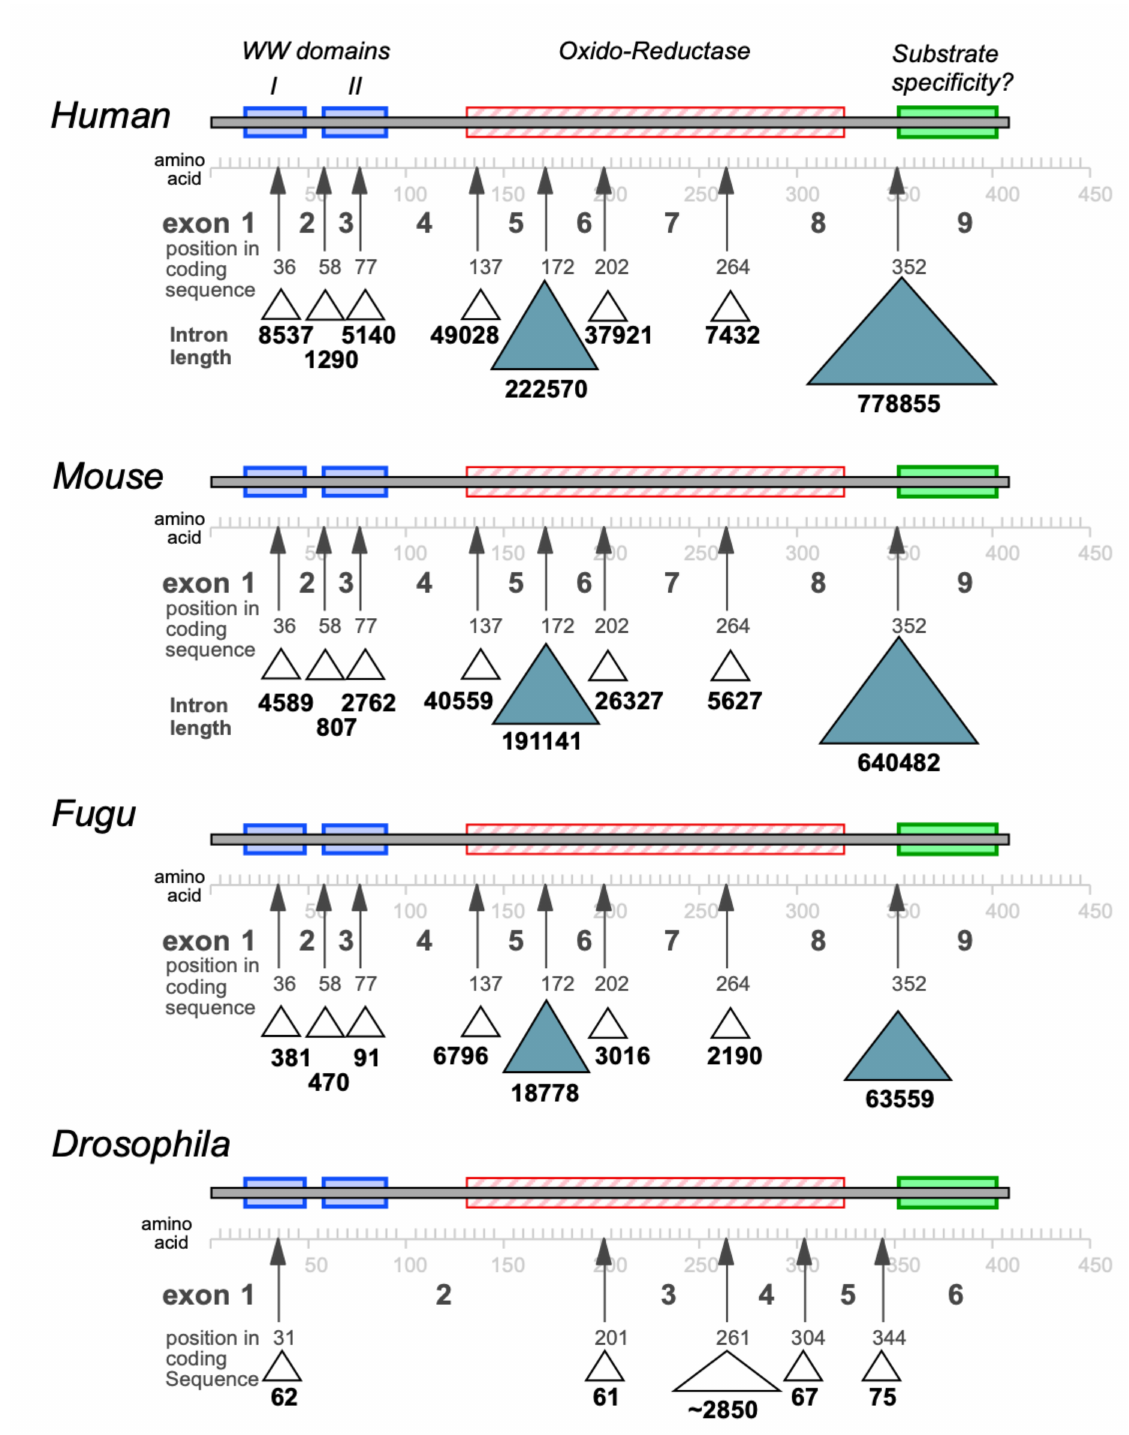
Figure 1. Location and length of introns in the WWOX genes of different species—with respect to major functional domains of the WWOX proteins of human, mouse, fugu and Drosophila